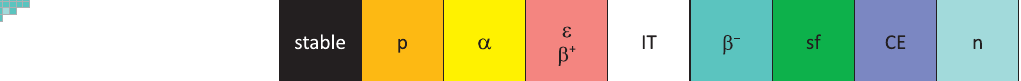
Fig. 1. Schematic diagram of the Karlsruhe Nuclide Chart showing the main